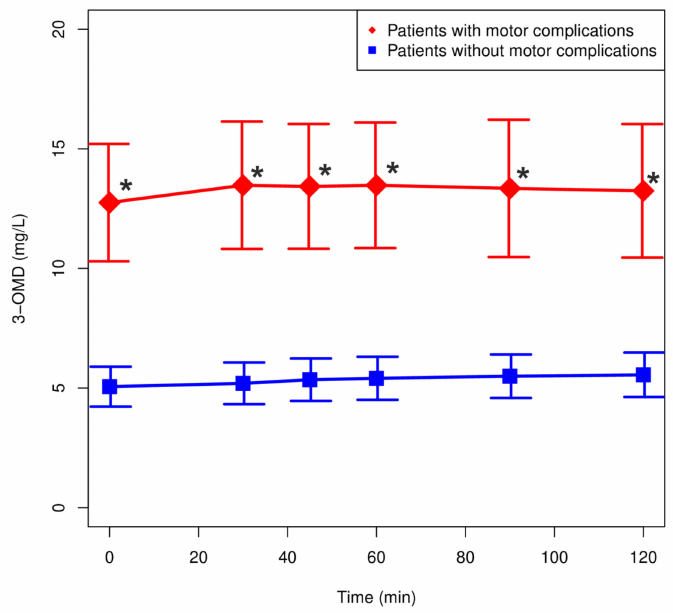
Figure 5. Plasma concentration: time profiles (mean values ± SEM) for 3-OMD of patients with motor complications (fluctuations and/or dyskinesias) and without motor complications. * p < 0.05.